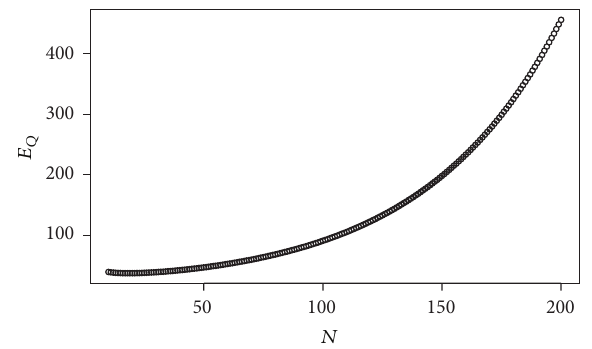
Figure 2: Figure depicts the expected time to extinction as a function of 𝑁 (10 to 200) where other parameters are as in Table